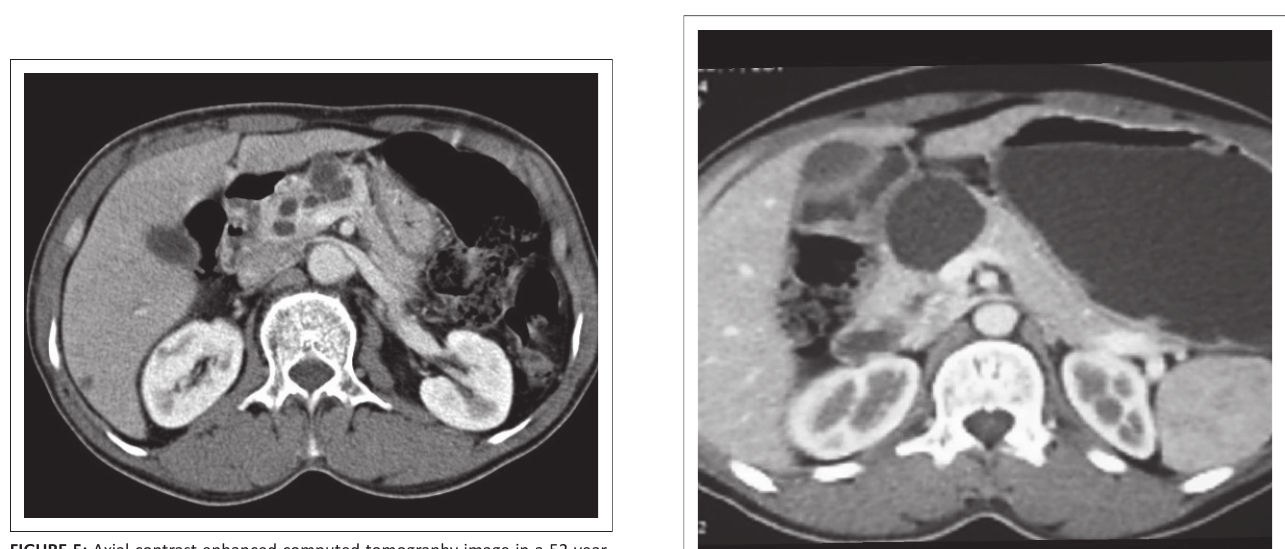
FIGURE 5: Axial contrast-enhanced computed tomography image in a 52-year- old male patient revealing a cystic lesion with septations in the body of pancreas with a dilated main pancreatic duct. A presumptive diagnosis of intra-ductal papillary mucinous neoplasm was made and histopathology examination confirmed the computed tomography diagnosis.